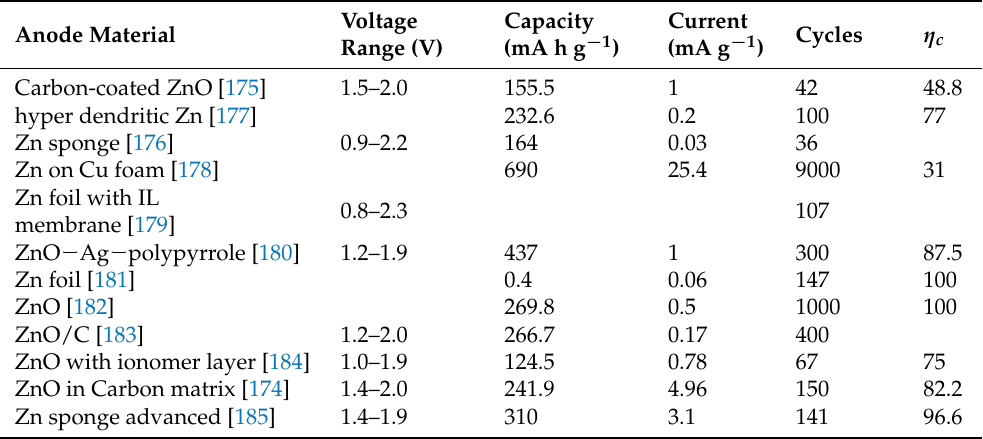
Table 5. Anode materials for Zn-based